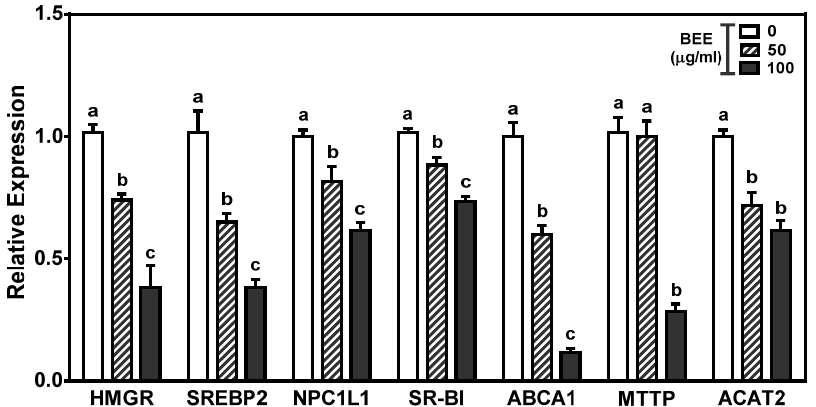
Figure 2. The effects of BEE on the genes involved in the synthesis and absorption of cholesterol in Caco-2 cells. Cells were treated with 50 or 100 µ g/mL BEE for 24 h. The messenger RNA (mRNA) abundance was measured by qRT-PCR analysis. Data are expressed as relative expressions to control. Bars with different letters are significantly different ( p < 0.05). Values are means ± SEM; n = 6.